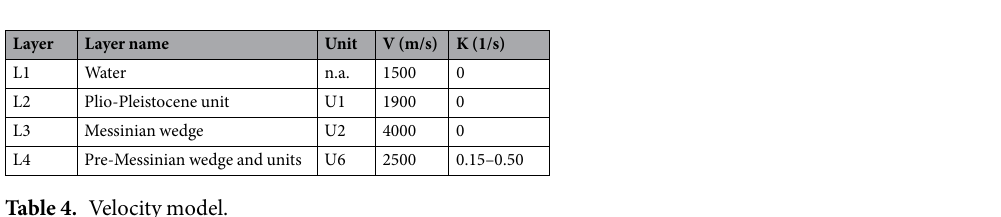
Figure 4. NW-SE seismic profile interpretation. Panel a - Seismic profile (profile #7 in Supplementary Figure S2). Horizon colour codes as in Fig. 2. Description of units (U1-9) and bounding horizons (H1-7) are reported in Tables 2 and 3, respectively. Yellow lines: unconformities within the Plio-Holocene basins (U1). Structural elements: Orange line: contractional structures within the accretionary wedge. Red line: subduction interface. Dark blue lines: extensional or transtensional faults. Key elements for the interpretation: 1 – Post- Messinian wedge; 2 - Relatively undisturbed sedimentary filling (U3 and U4) of the Ionian basin; 3 - Frontal splays (presumably involving U2); 4 - Accretionary wedge (U6); 5 - Inner thrust involving U7; 6 - Plio-Holocene forearc basin. Dashed vertical lines indicate the intersection with profile #14 (Fig. 5 and Supplementary Figure S3) and profile CROP M2B (Fig. 3). Panel b – Detail of the seismic line in a display using the energy attribute showing the position of the subduction interface (black arrows). Panel c – Detail of the seismic line showing the position of the subduction interface (black arrows), the deformed unconformity H2 (white arrows), and the deformed seafloor H1 (grey arrows). Raw seismic data provided by Spectrum Geo (http://www.